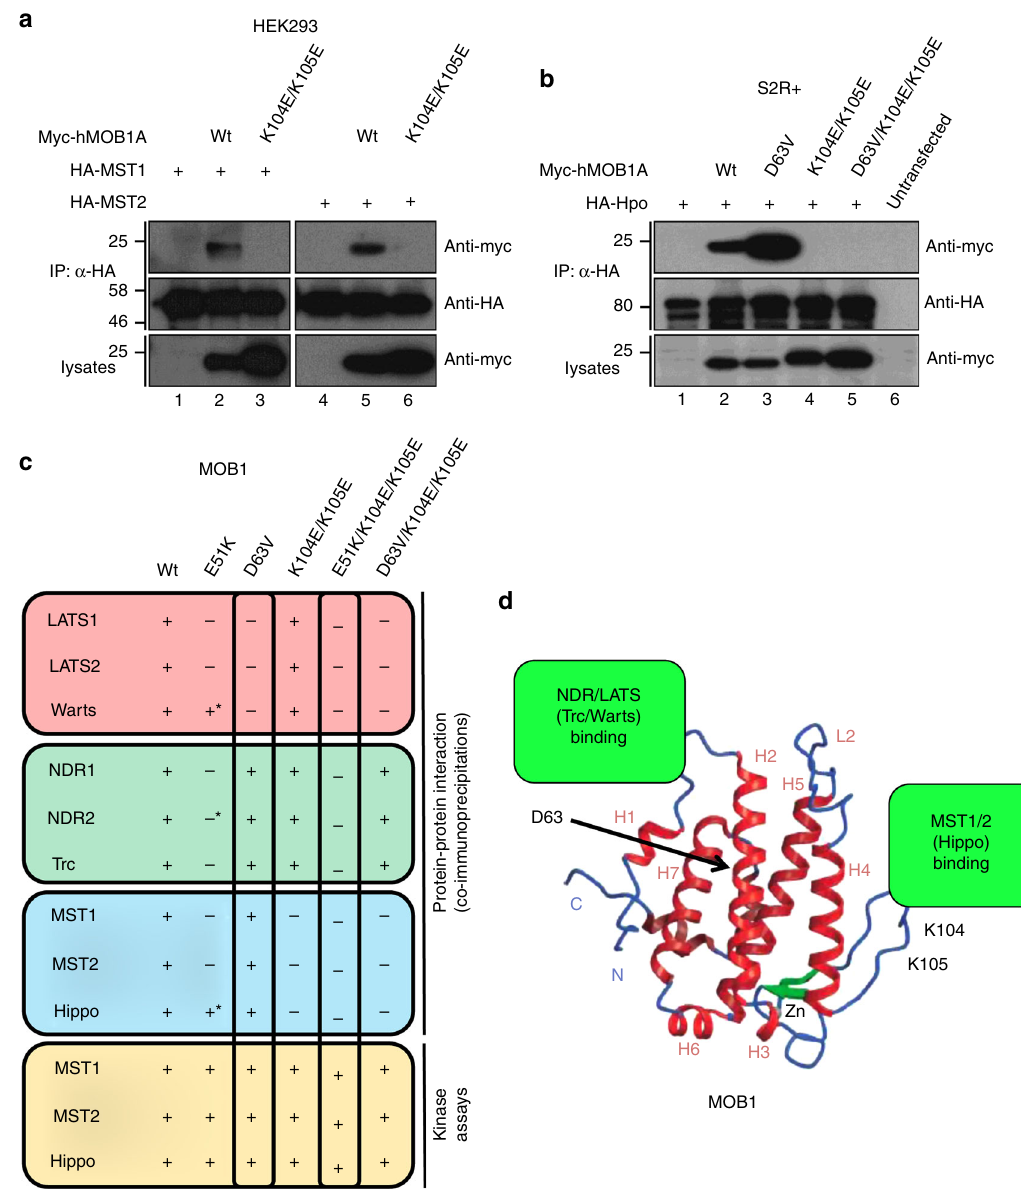
Fig. 3 De fi nition of MOB1 variants with selective loss-of-interaction with Hippo core kinases. a Lysates of HEK293 cells expressing full-length HA-MST1 or HA-MST2 wild-type ( wt ) together with indicated full-length MOB1A versions were subjected to immunoprecipitation ( IP ) using anti-HA. Complexes were studied by immunoblotting using anti-myc ( top ) and anti-HA ( middle ). Input lysates were analyzed with anti-myc ( bottom ). The K104E/K105E mutations caused loss of binding to MST1/2. See Supplementary Fig. 19 for uncropped western blots. b Lysates of Drosophila S2R + cells expressing full-length HA- Hpo(wt) together with indicated full-length MOB1A versions were subjected to IP using anti-HA. Complexes were studied by immunoblotting using anti- myc ( top ) and anti-HA ( middle ). Input lysates were probed with anti-myc ( bottom ). Relative molecular weights are shown. See Supplementary Fig. 19 for uncropped western blots. c Schematic summary of the biochemical and molecular characterization of the indicated MOB1A variants presented in Supplementary Figs. 5 – 13. Noteworthy, NDR2 weakly interacted with MOB1(E51K), and Warts and Hpo bound normally to the E51K mutant as judged by co-immunoprecipitation experiments (marked by an asterisk ), hence the E51K mutant was not studied further. d Model of human MOB1A(33 – 216) depicting the possibly opposing binding sites on MOB1 of NDR/LATS and MST1/2 kinases. Secondary structure elements of MOB1 are highlighted. The locations of Glu51, Asp63, and Lys104/Lys105 in MOB1 are